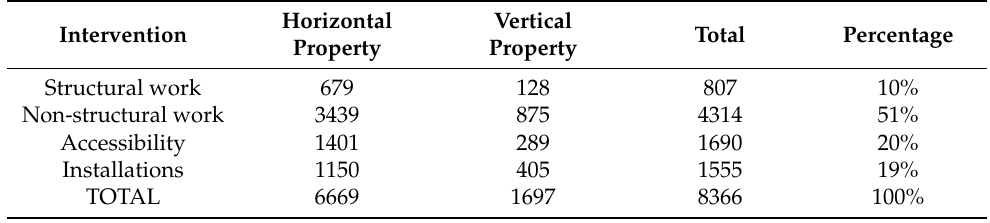
Table 2. Interventions subsidized from